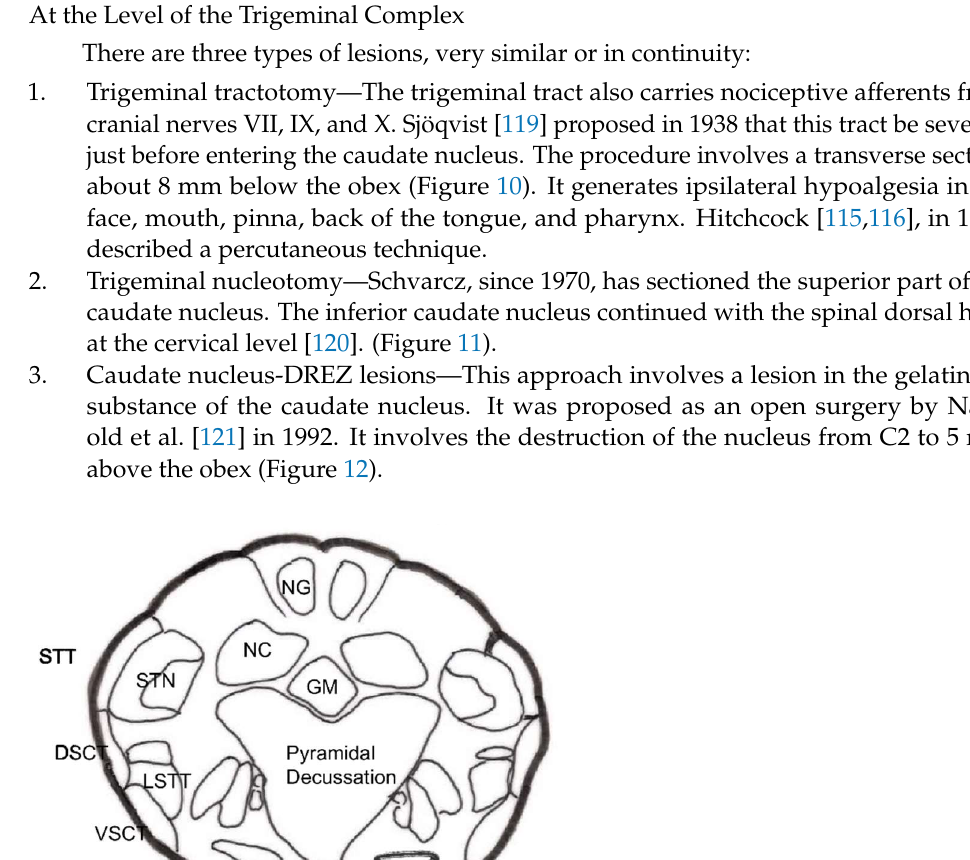
Figure 11. Trigeminal nucleotomy (see text). Section approximately 18 mm below the obex (modi- fied from [122]). GF—Gracile Fasciculus. CF—Cuneate Fasciculus. STrigT—Spinal Trigeminal Tract. STrigN—Spinal Trigeminal Nucleus. AECT—Anterior Spinocerebellar Tract. PECT—Posterior Spinocerebellar Tract. LCET—Lateral Corticospinal Tract. GP—Gelatinosa Portion of Spinal Tri- geminal Nucleus. MC—Magnocelllular Portion of Spinal Trigeminal Nucleus. RST—Rubrospinal Tract. ALS—Anterolateral System. Figure 12. Sections at the level of the obex and 2–3 mm below (modified from [122]). GN—Gracile Nucleus. CN—Cuneate Nucleus. RB—Restiform Body. STrigT—Spinal Trigeminal Tract. STrigN— Spinal Trigeminal Nucleus. AECT—Anterior Spinocerebellar Tract. ALS—Anterolateral System. ON—Olivary Nucleus. ML—Medial Lemniscus. P—Pyramid. X—Dorsal Motor Nucleus of Vagus. XII—Hypoglossal Nucleus.